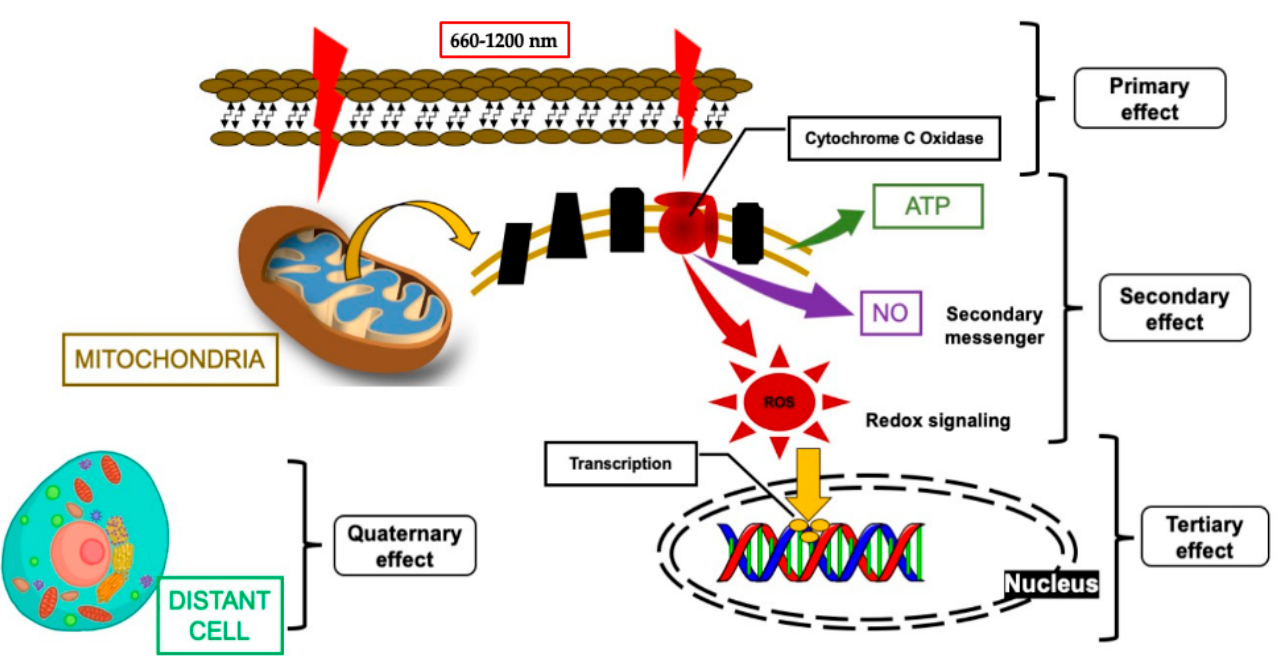
Figure 2. Modified schematic description of the of mechanism of action for PBM, highlighting its four effects: the primary effects (photonic energy absorption by cytochrome C Oxidase (CCO)), secondary effects (mitochondrion of ATP, NO, and ROS), tertiary effects (downstream of intracellular responses effects (mitochondrion of ATP, NO, and ROS), and quaternary effect (indirect/distant effects such as gene transcription and cellular signaling) [21]. Abbreviations: PBM, photobiomodulation; ROS, reactive oxygen species; NO, nitric oxide; ATP, adenosine triphosphate.